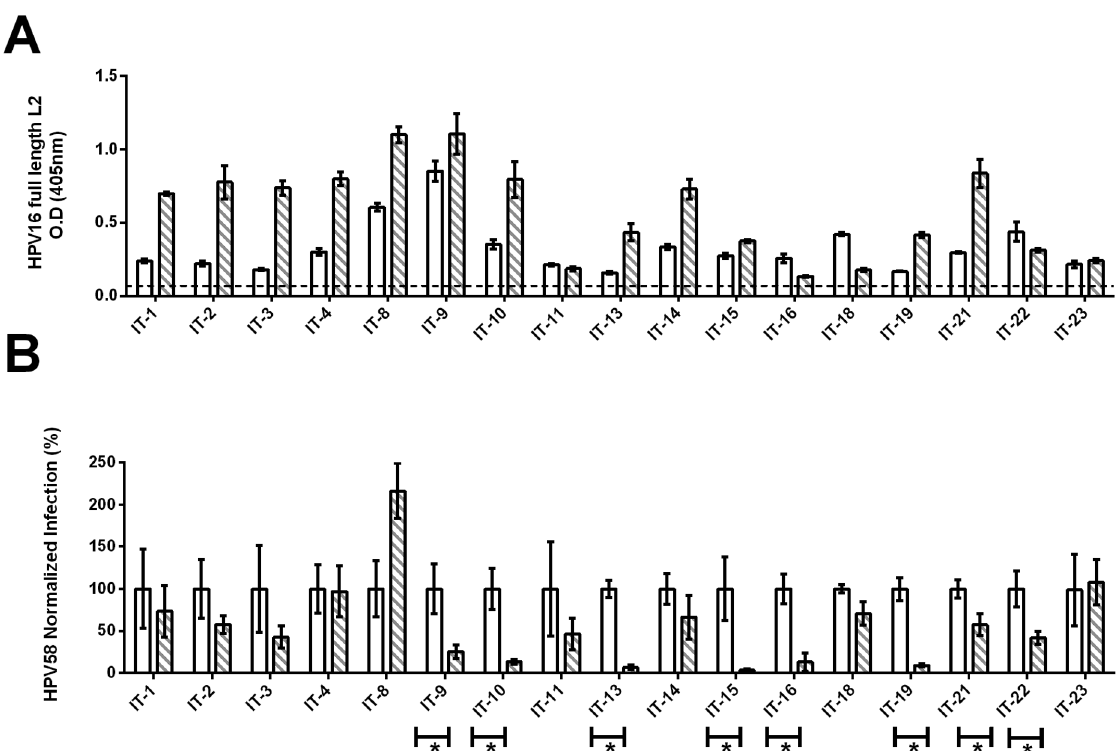
Figure 2. Assessment of TA-CIN sera (n=17). HPV16 full length L2 ELISA using sera of patients vaccinated with TA-CIN was performed in triplicate and is presented as mean 6 Standard deviation (A). Results of in vivo passive transfer studies with patient sera. Asterisk indicates significant difference in mean infection of the five mice per group 6 standard error against intra vaginal HPV58 challenge observed between pre- and post- vaccinated sera (100 m L per mouse) (B). For both figures, white bars indicate pre-vaccinated serum and hashed bars indicate post-vaccinated